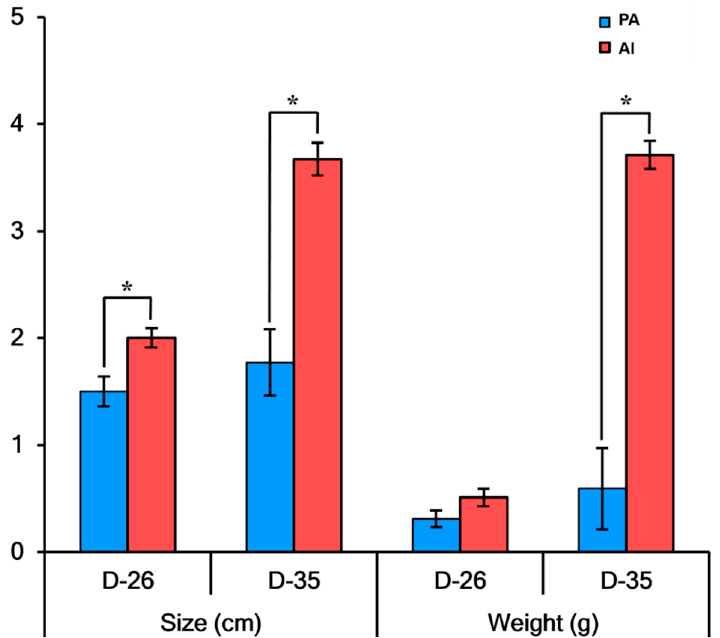
Figure 1. Sizes and weights of parthenogenetically activated (PA) and artificially inseminated (AI) embryos and fetuses. PA and AI embryos and fetuses were collected at day 26 and day 35 after embryo transfer. Immediately after collection, the embryos and fetuses were washed and their developmental characteristics such as size and weight were examined. * PA vs. AI ( p < 0.05)